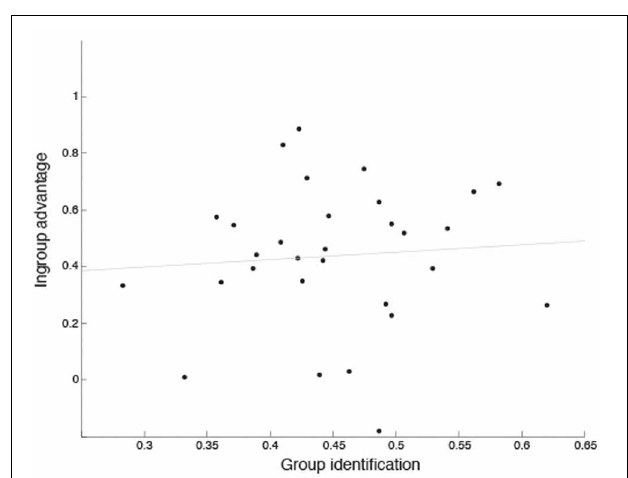
separately. Red lines are the medians, box edges are the 25th and 75th percentiles, and the whiskers extend to the most extreme data points excluding outliers.